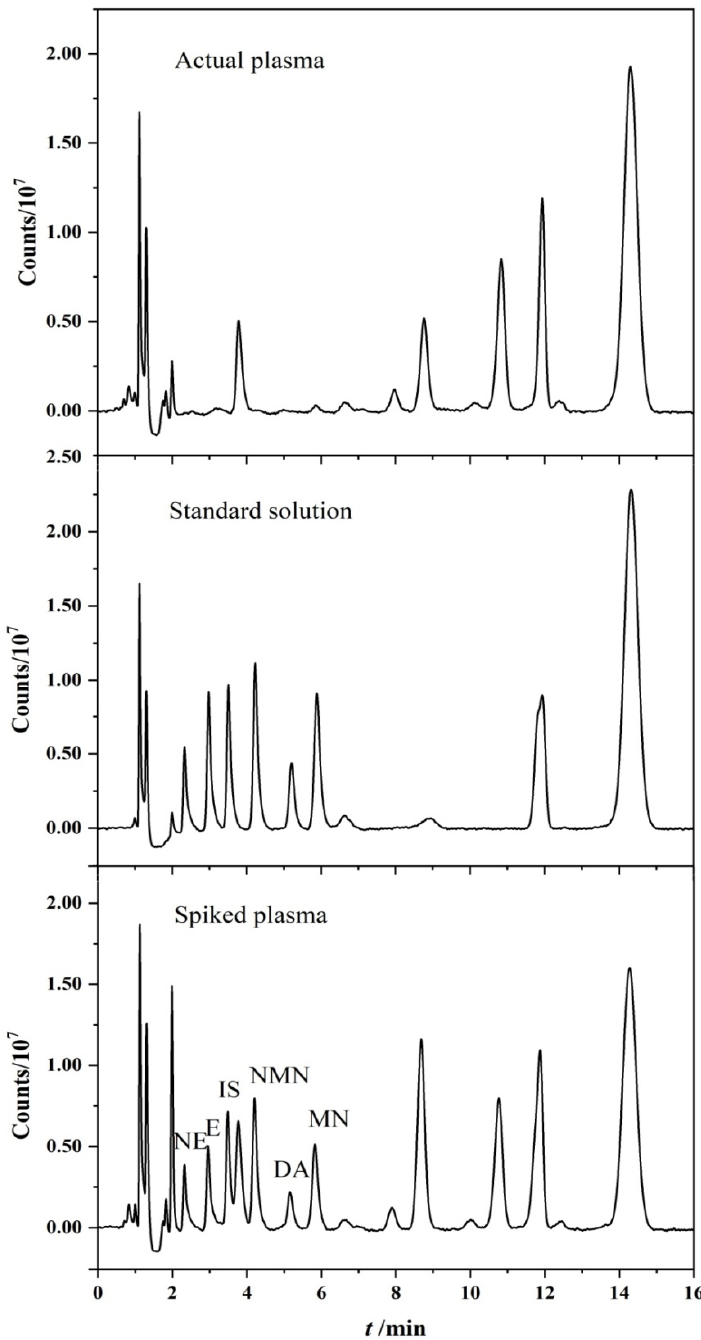
Figure 6. Chromatograms of spiked plasma (10 ng/mL of CAs and 200 ng/mL of NMN and MN), standard solution (10 ng/mL) and actual plasma using off-line PFSPE–HPLC method.